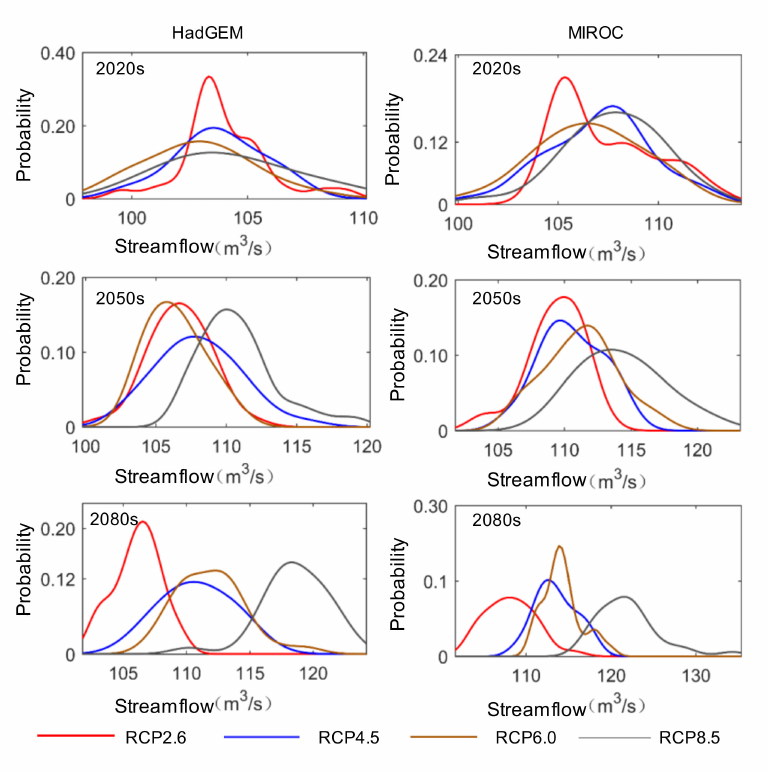
Figure 7. Distributions of annual streamflow in di ff erent